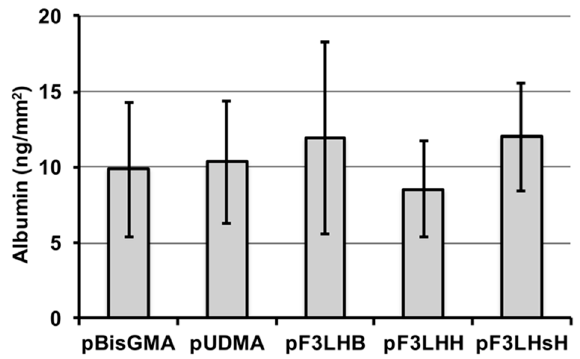
Figure 5. Albumin (HSA) adsorption following 1 h of incubation and 24 h of elution with 2% SDS solution for select fluorinated polymers and controls ( n = 14, ± SD).